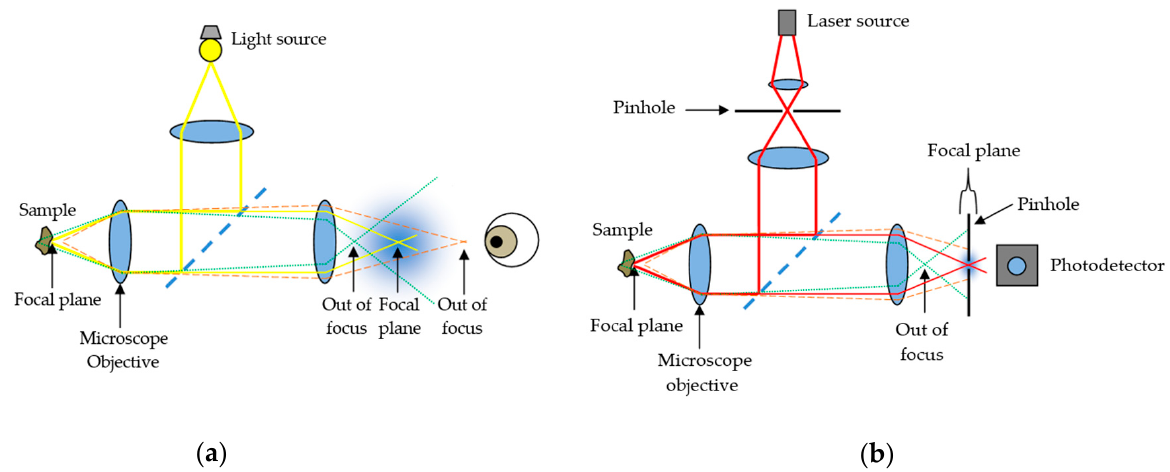
Figure 1. Comparison between ( a ) conventional optical microscopy and ( b ) confocal laser scanning microscopy.